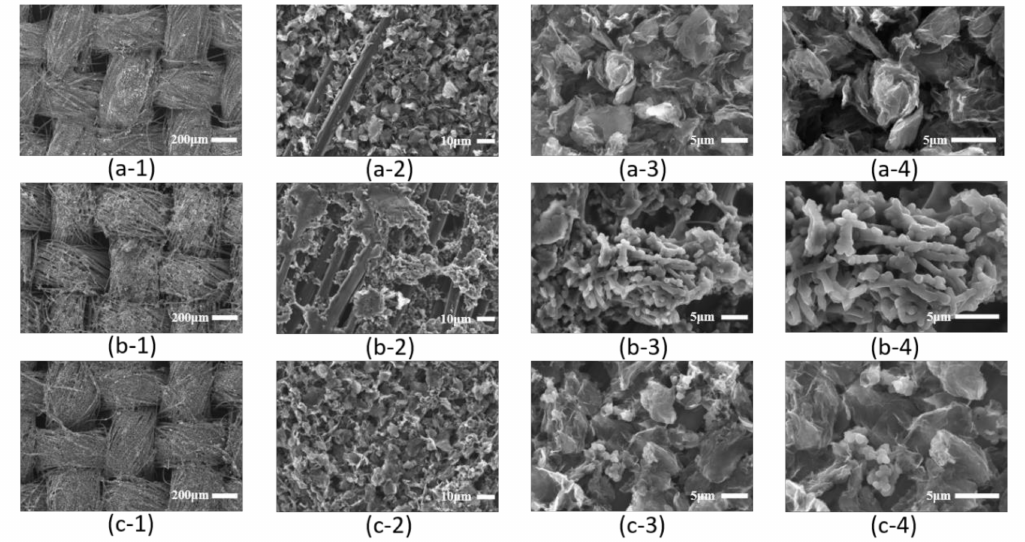
Figure 2. SEM images. rGO/CS electrodes with ( a-1 ) 70 × , ( a-2 ) 1000 × , ( a-3 ) 3000 × , and ( a-4 ) 5000 × magnification; PPy/CS electrodes with ( b-1 ) 70 × , ( b-2 ) 1000 × , ( b-3 ) 3000 × , and ( b-4 ) 5000 × magnification; and rGO/PPy/CS electrodes with ( c-1 ) 70 × , ( c-2 ) 1000 × , ( c-3 ) 3000 × , and ( c-4 ) 5000 ×